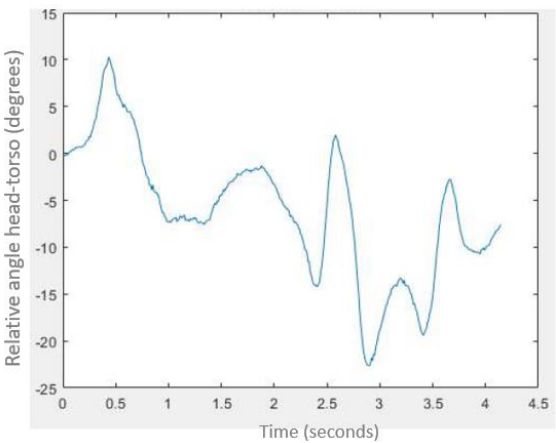
Figure 11. Relative angle between head and torso during BT1.